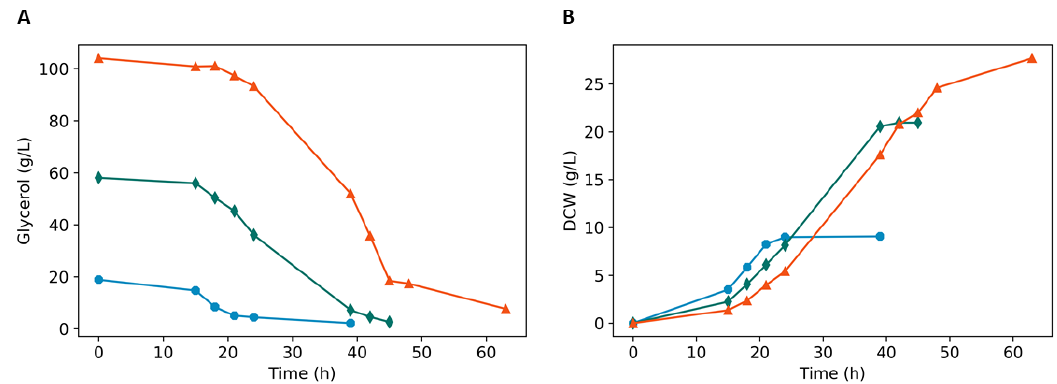
Figure 2. GLp batch aerobic culture showing the consumption of glycerol ( A ), biomass ( B ) in different initial glycerol concentrations: 2% (blue circle), 6% (green diamond), and 10% (orange triangle). All fermentations were with the GLp strain. The experiments were carried out in biological duplicates, and the figure shows a typical fermentation profile.